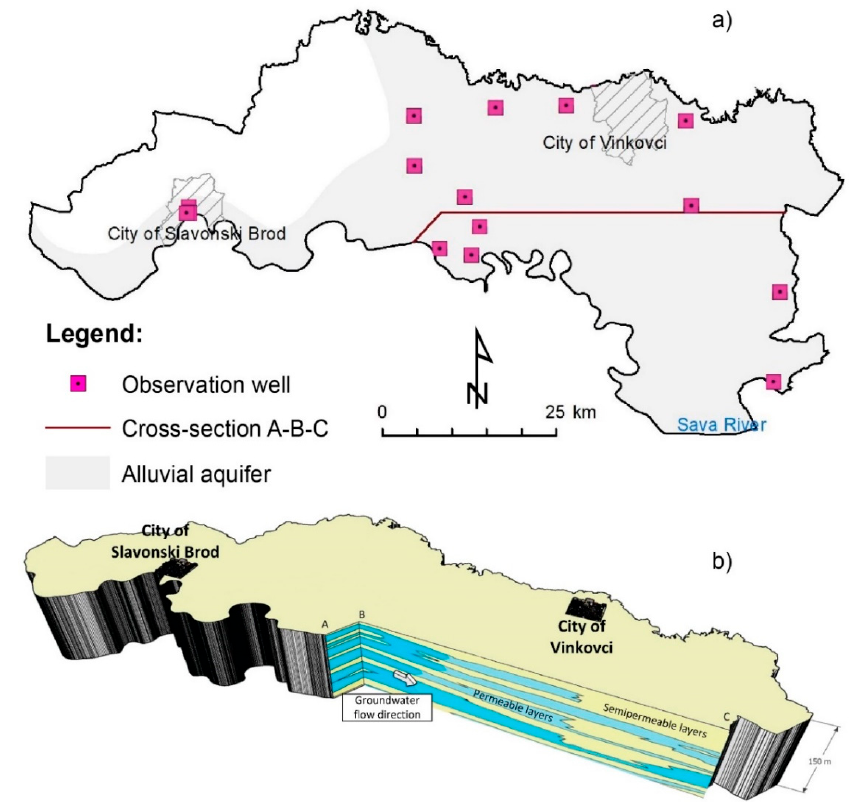
Figure 4. Conceptual model of the groundwater body CSGI_29: ( a ) Planar extent of the groundwater body; ( b ) Schematic 3D hydrogeological cross-section.